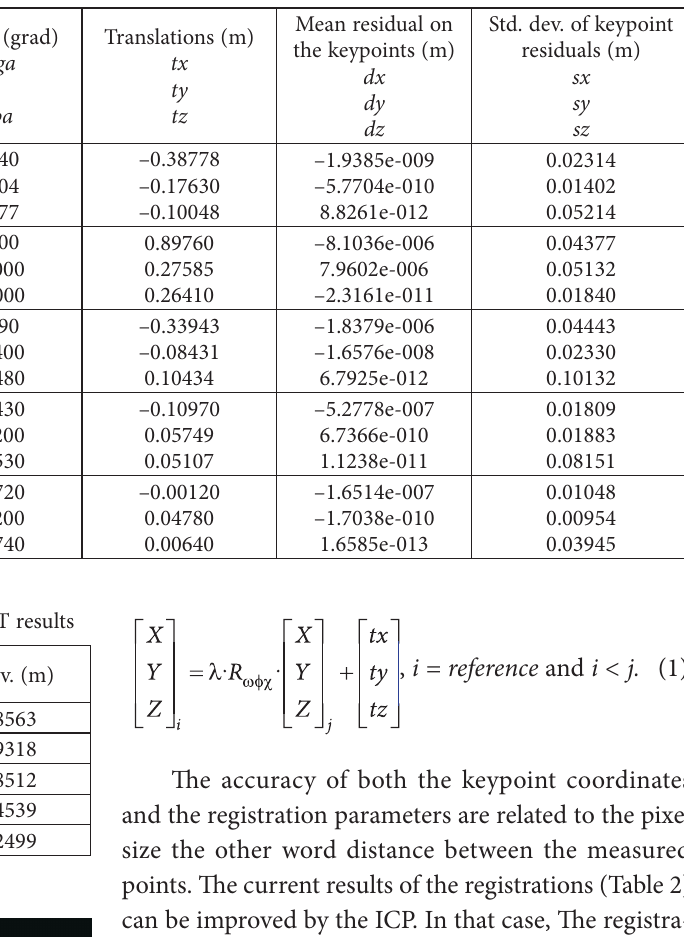
Table 2. The registration results achieved by SIFT and residuals on the keypoints (case study 3)